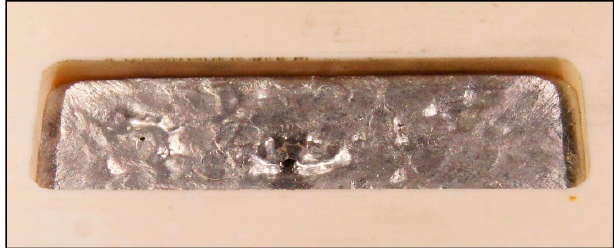
Figure 3. The cavity of the alumina sample filled with field’s metal after solidification.